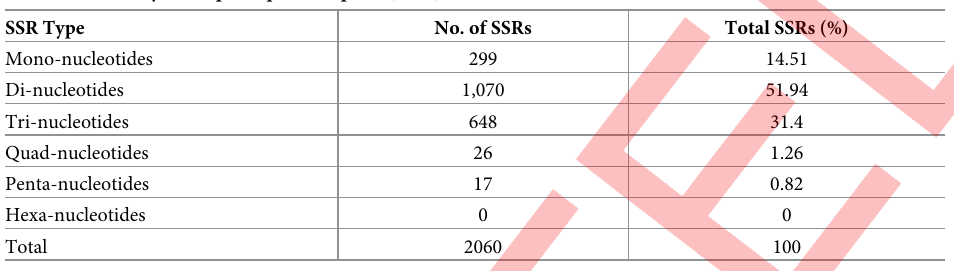
Table 4. Summary of simple sequence repeats (SSRs).